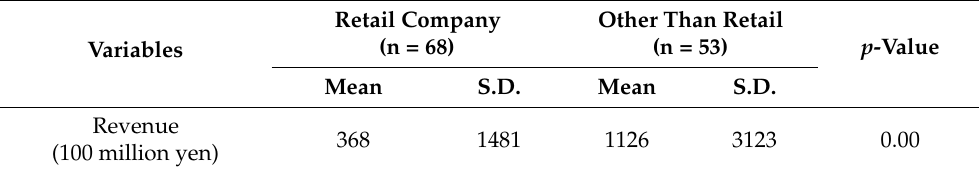
Table 2. Corporate revenue of retailers and non-retailers among entering company